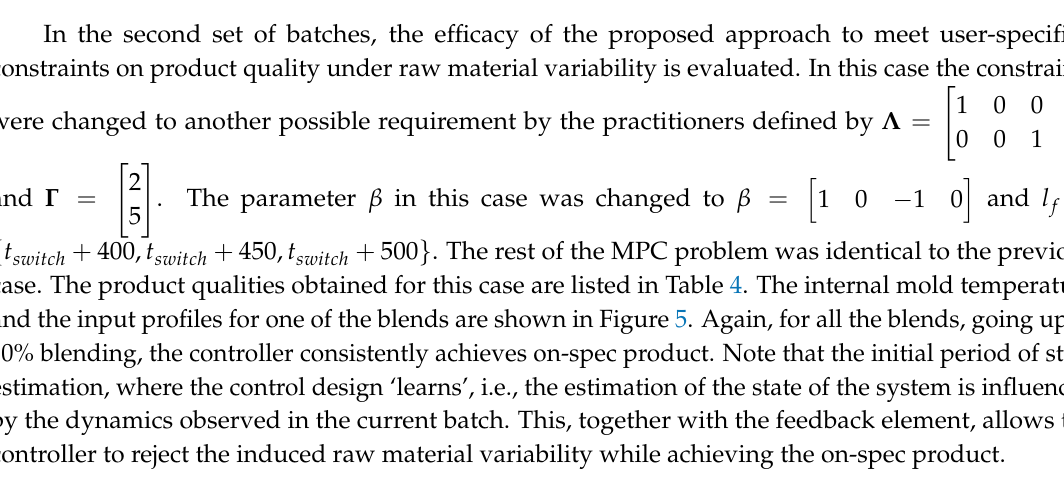
Figure 4. Zero-blend constrained case.